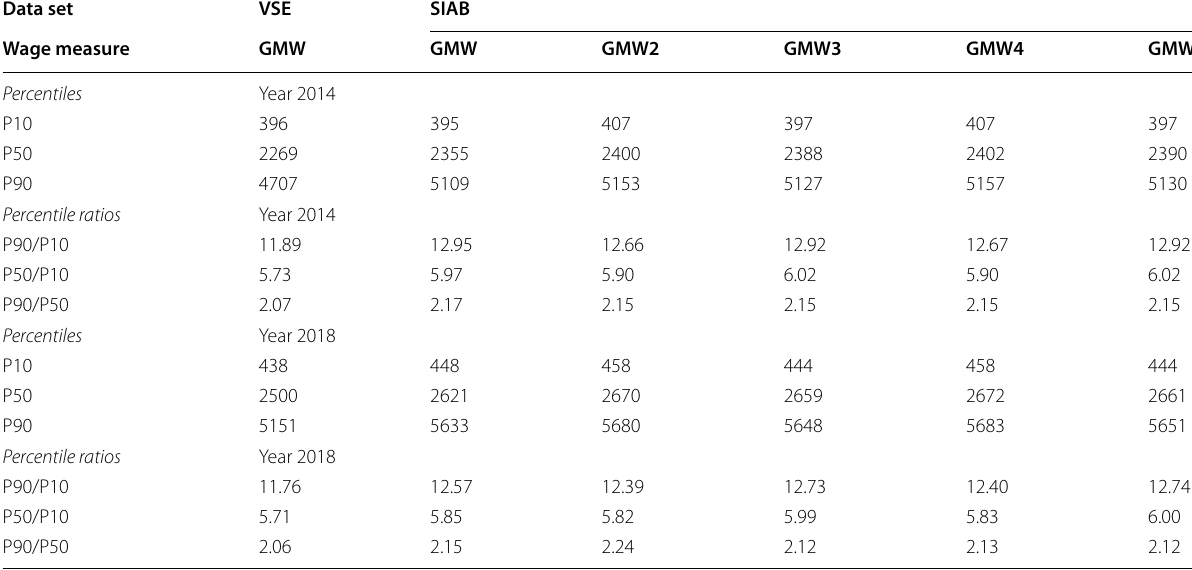
Table 10 Selected 2014 and 2018 wage percentiles and wage percentile ratios for VSE and